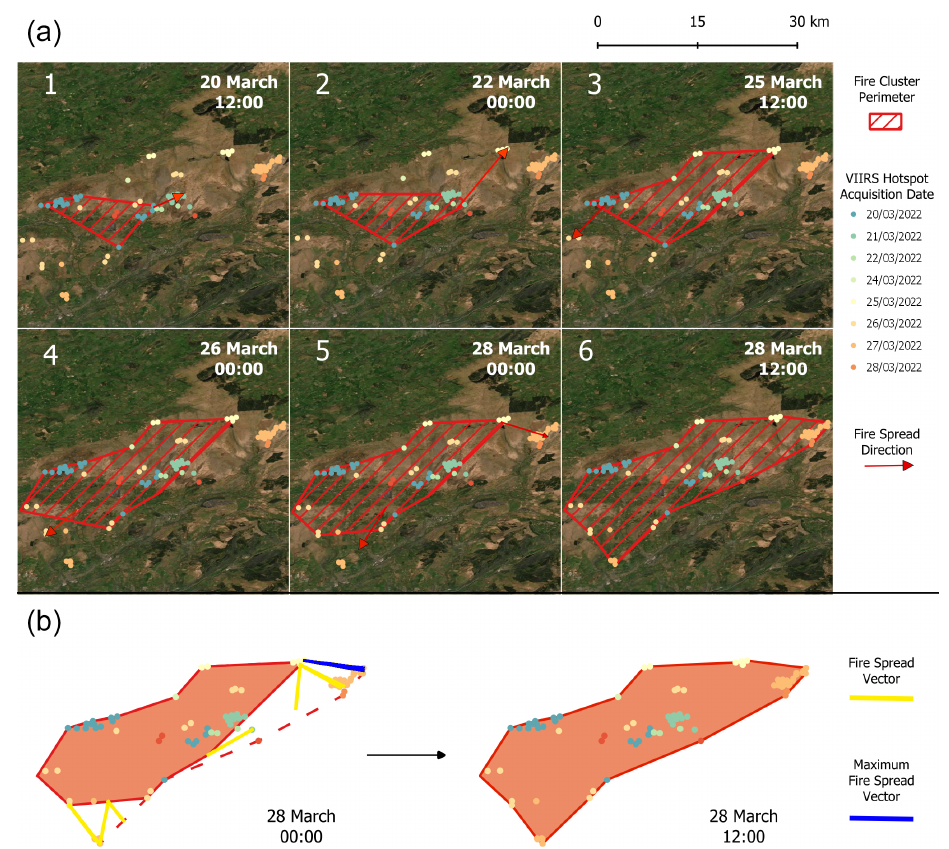
Figure 2. Multipolygons and rate of spread (ROS) vectors for the Mynydd Mawr fire in Wales (20 March 2022), representing the methodology used to delineate fire perimeters and rate of spread (ROS) vectors. (a) Schematic of the fire growth in several time steps throughout the fire duration, delineated using the VIIRS hotspots (VIIRS 375m active fire product at each satellite overpass) (VNP14IMGTDL_NRT; https: //firms.modaps.eosdis.nasa.gov/download/, last access: August 2022). Red arrows represent the main fire spread direction schematically. (b) Real ROS vectors (yellow lines) and perimeters generated (orange polygons) in two selected satellite overpasses. For each time step, the maximum ROS vector is selected for further analyses (blue lines), representing the ROS in the head of the